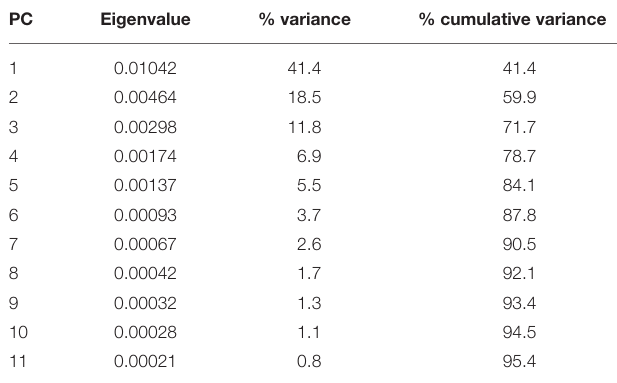
TABLE 2 | Summary of the results of the principal component analyses of the brain outlines of different specimens of turtles and other